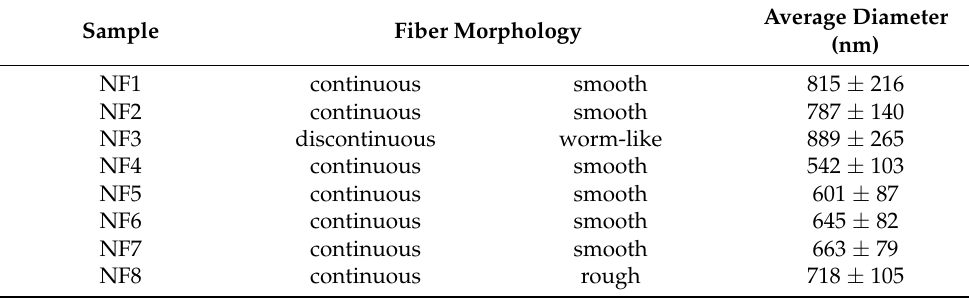
Table 3. Fiber morphology and average diameter for different formulations.